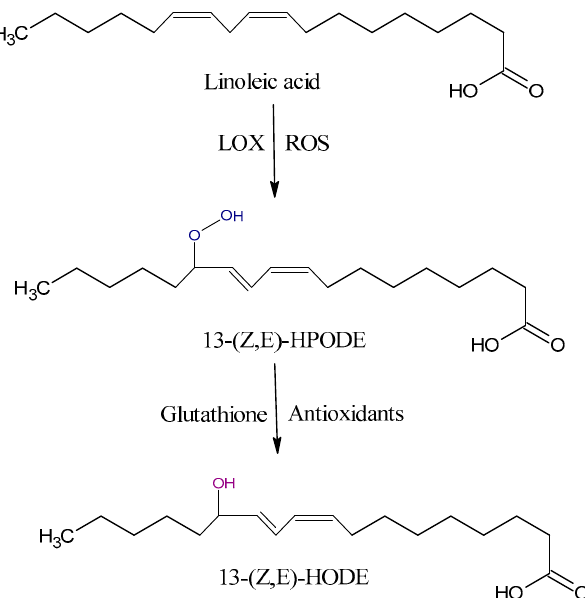
Figure 2. Some of oxidation products from linoleic acid (LA). HPODE, hydroperoxyoctadecadienoic acid; HODE, hydroxyoctadecadienoic acid; LOX, lipoxygenase.